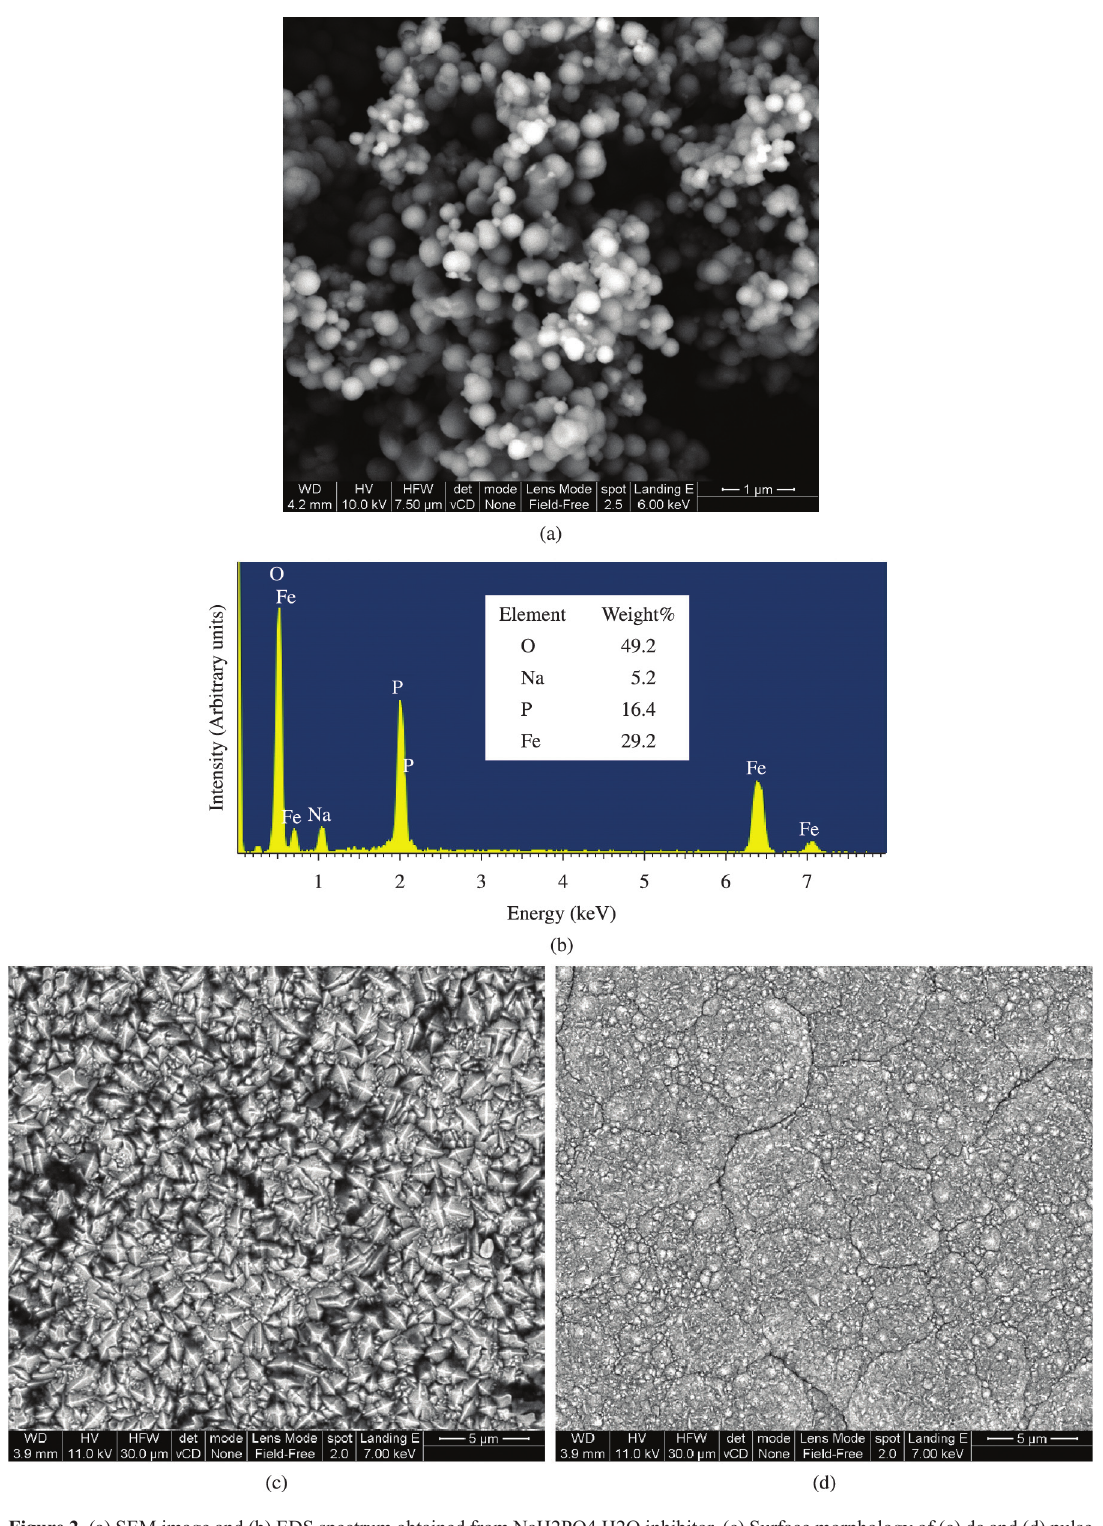
Figure 2. (a) SEM image and (b) EDS spectrum obtained from NaH2PO4.H2O inhibitor. (c) Surface morphology of (c) dc and (d) pulse plated Ni covering inhibited carbon